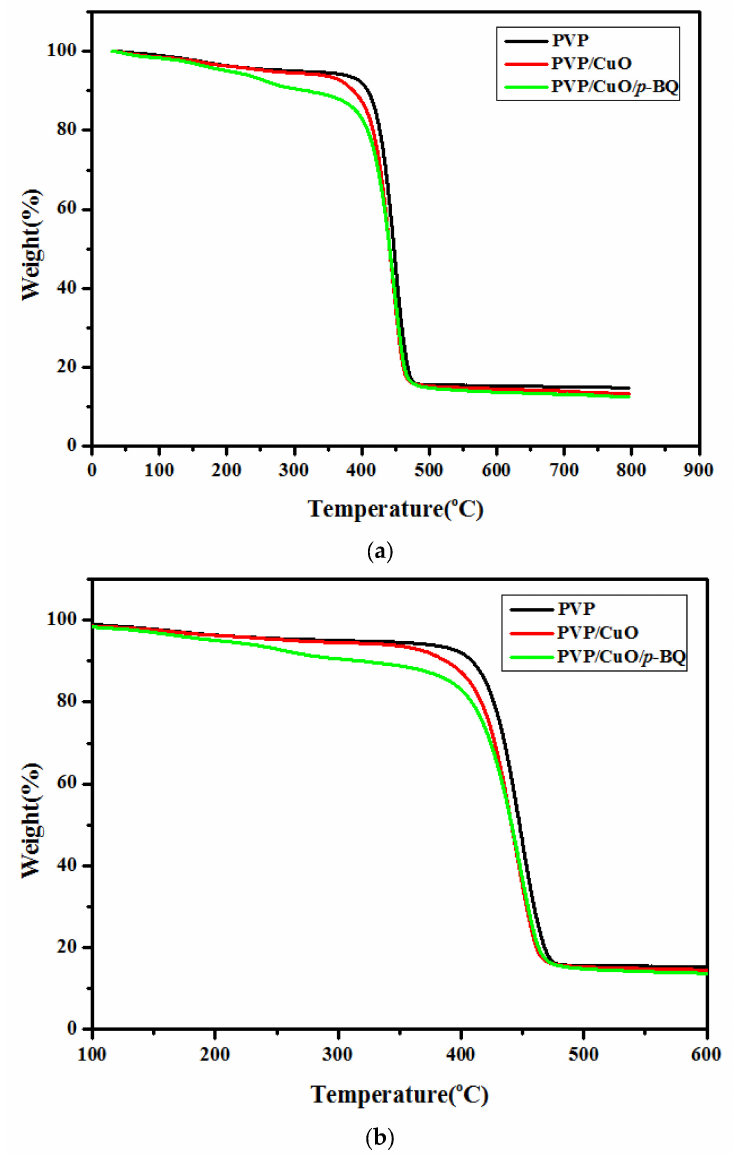
Figure 4. TGA curves of ( a ) PVP, PVP/CuO, and PVP/CuO/ p -BQ composites and ( b ) enlarged